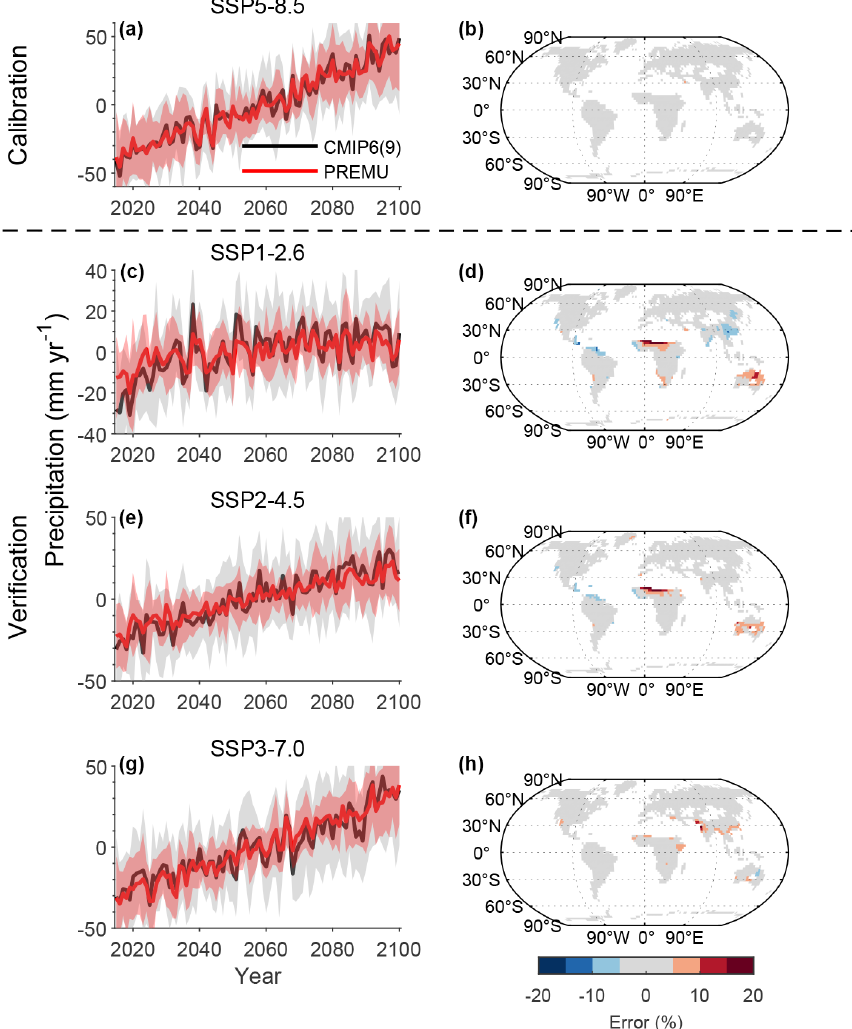
Figure 5. The emulation of future precipitation: (a) multi-model mean GLAP in nine ESMs from CMIP6 (the sixth phase of the Coupled Model Intercomparison Project; CMIP (9)) and the precipitation prediction by our emulator (PREMU) in 2015–2100 under the SSP5–8.5 scenario. The shaded area represents the mean ± SD. (b) The spatial pattern of error in MAP during 2071–2100 for the multi-model mean and our emulator. (c, d) SSP1–2.6; (e, f) SSP2–4.5; (g, h)